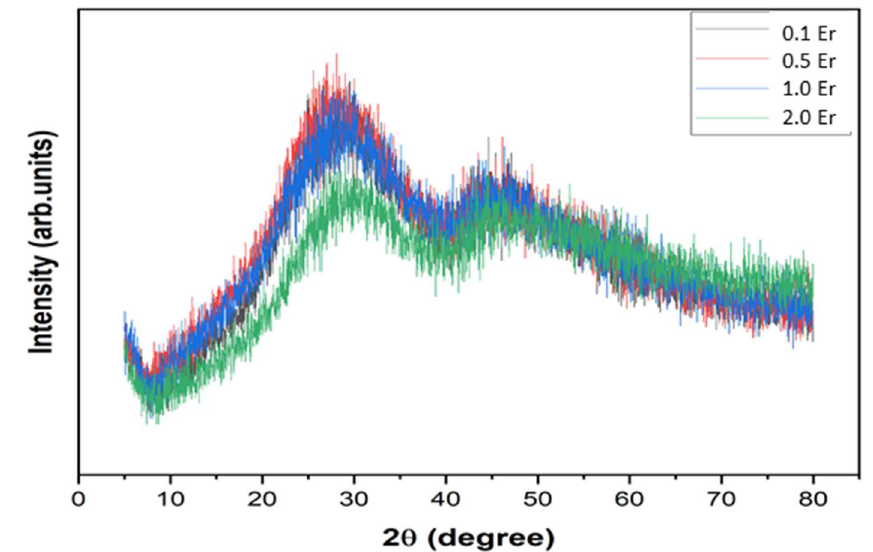
Figure 1. XRD of Er 2 O 3 doped ZBB glasses.